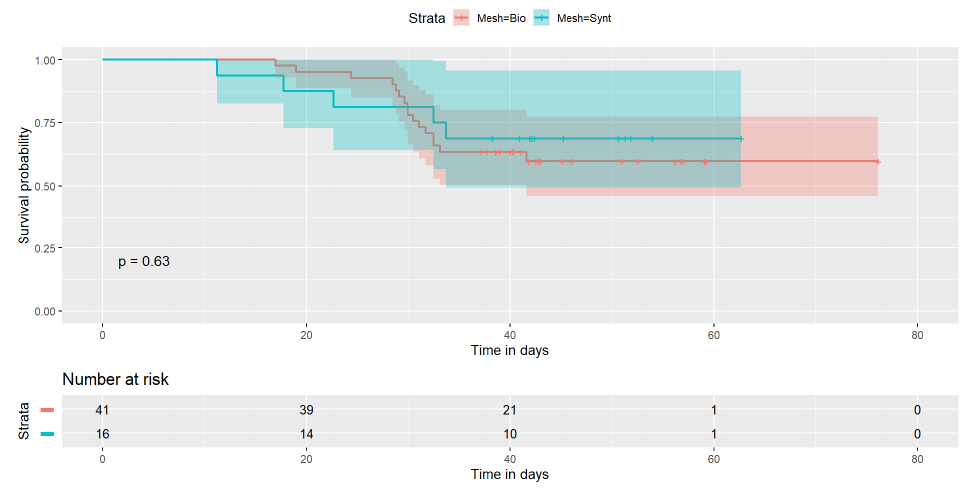
Figure 2. Kaplan–Meier chart stratified for type of mesh. Table 4. Cox regression model for VH recurrence.